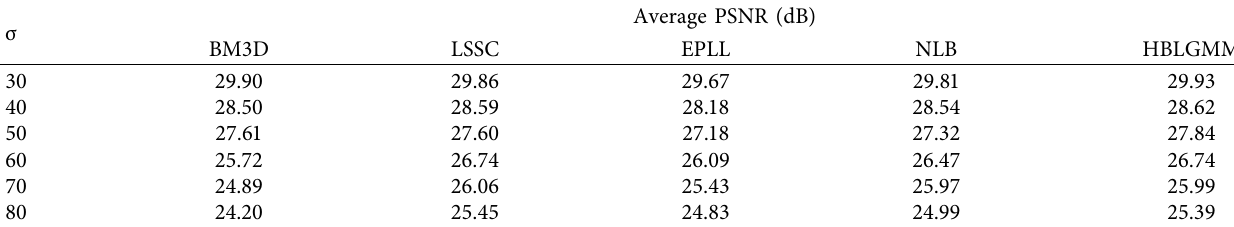
Table 5: Comparison of denoising